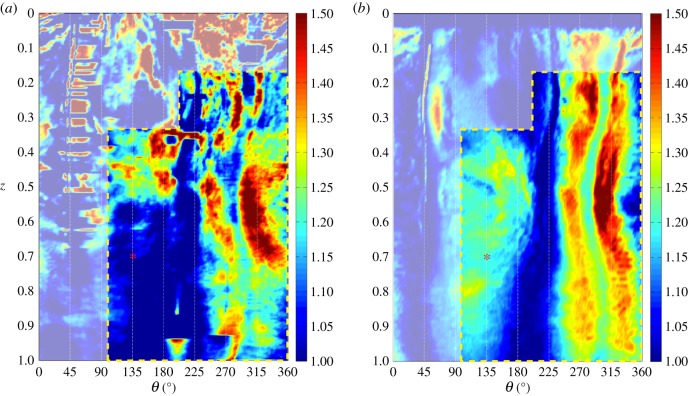
Colour map of changes in cortical thickness, ΔTh/Th, measured for in vivo data (a) against the respective predictions using ΨA = 50 MPa (b). The red asterisk is placed at Z = 0.7 and θ = 135°. Artefacts in the experimental data calculations predominate in the region masked over, outside the yellow dashed line. (a) micro-CT scan and (b) simulation.